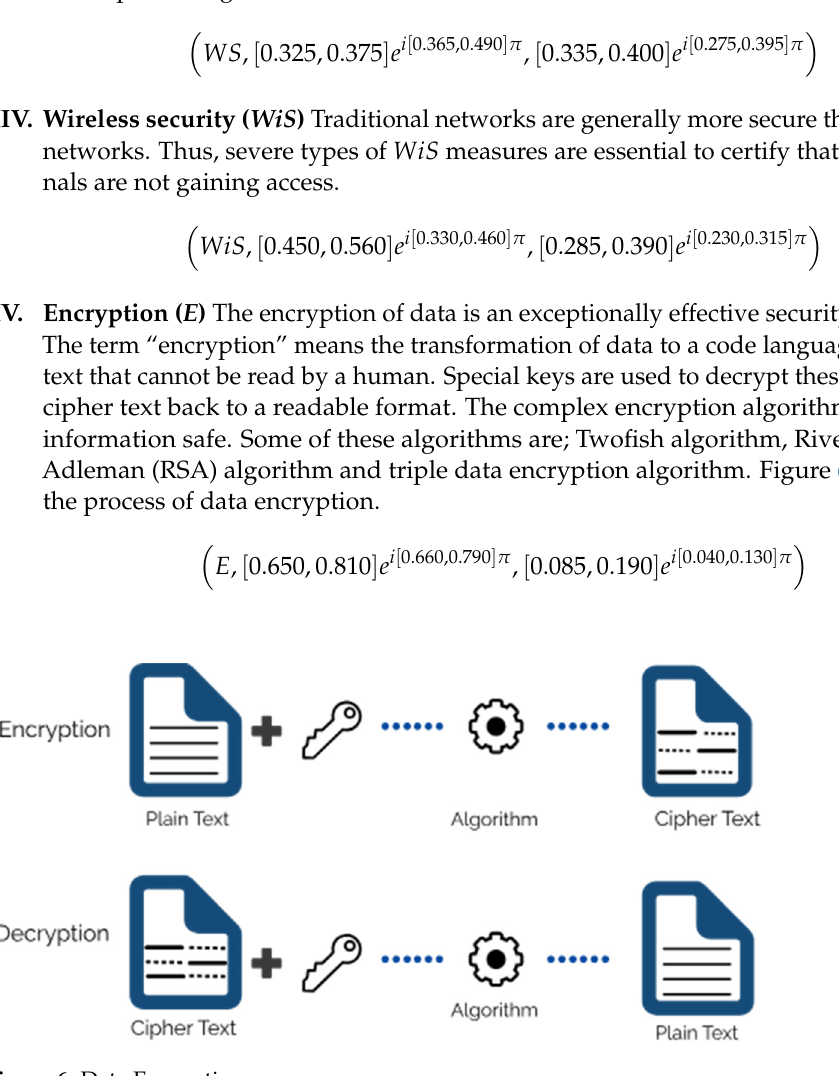
Figure 6. Data Encryption.